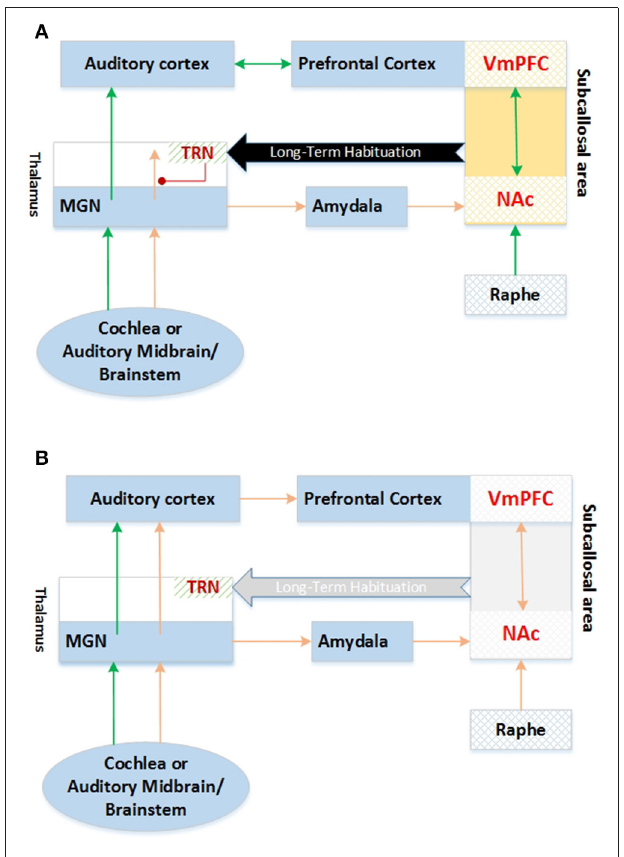
FIGURE 2 | Tune out model of Tinnitus MGN, Medial Geniculate Nucleus; TRN, Thalamus Reticular Nucleus; VmPFC, Ventromedial PreFrontal Cortex; NAc, Nucleus Accumbens (A) Compensated Tinnitus, (B) Tinnitus. Adapted from Rauschecker et al. (2010). FIGURE 3 | Tinnitus core model. Adapted from De Ridder et al.